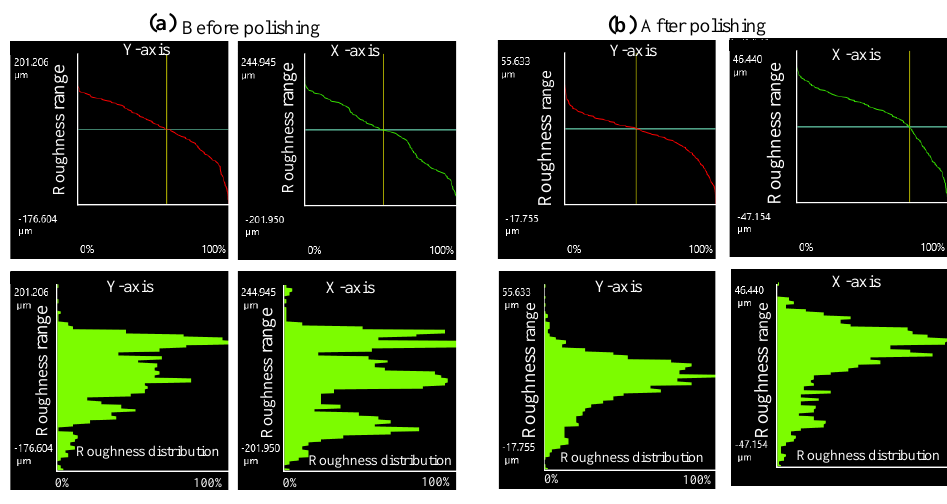
Figure 14. Surface roughness analysis of P0-path1 before and after polishing.